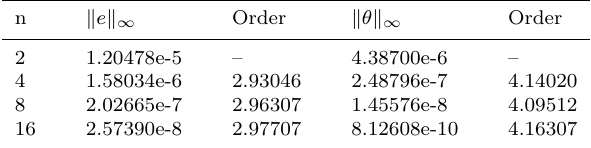
Table 4. Numerical results for example 2.